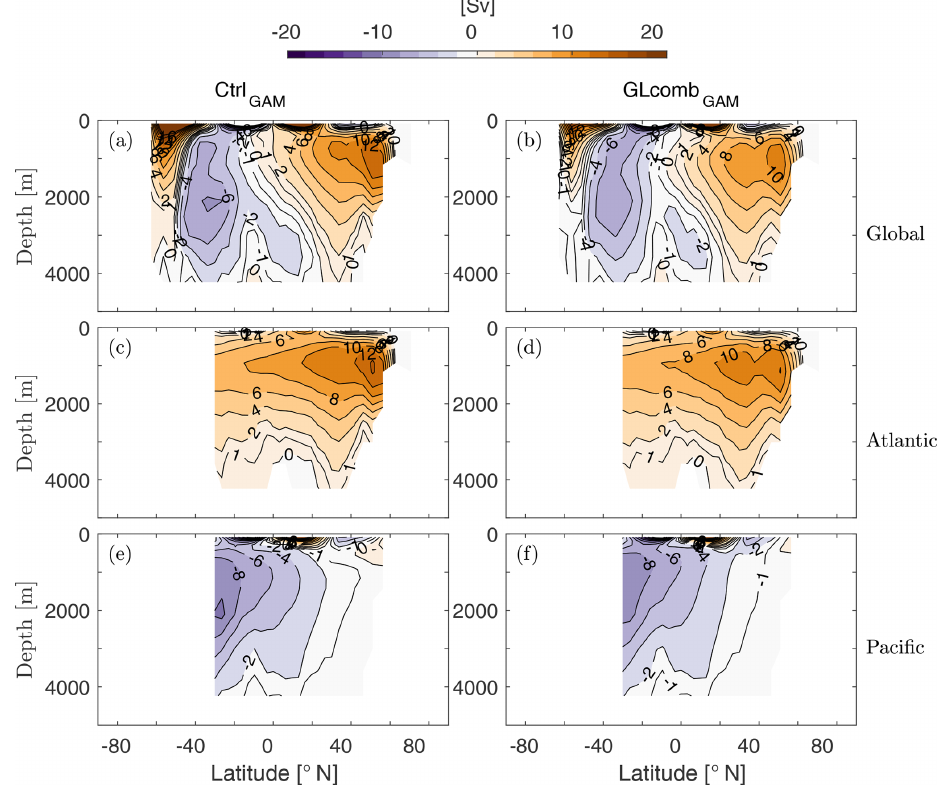
Figure 2. The Eulerian component of the global (a, b) , Atlantic (c, d) , and Pacific (e, f) ocean meridional overturning stream function (1Sv = 10 6 m 3 s − 1 ) of Ctrl GAM (a, c, e) and GLcomb GAM (b, d, f) . Note that the eddy-induced transport of tracers is taken into account through a skew-diffusive flux (Griffies, 1998) that is present in the velocity fields used to compute the Eulerian stream